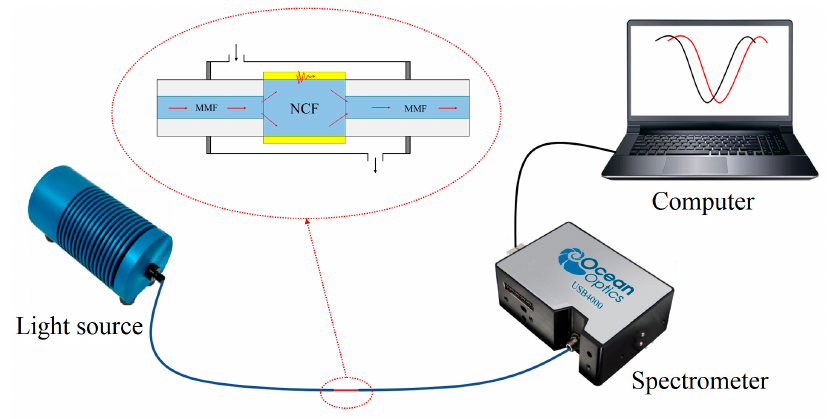
Figure 3. Experimental setup for investigating the sensing properties of the simple hetero-core optical fiber (MMF-NCF-MMF) structure.